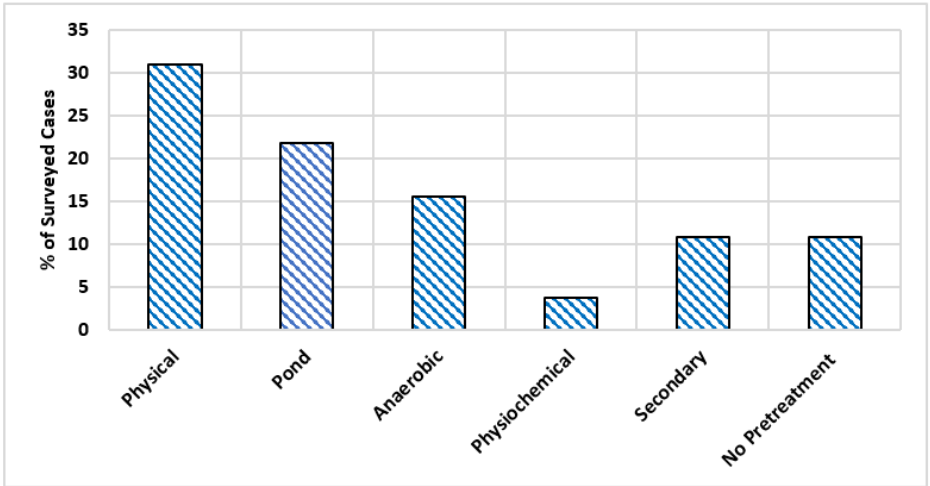
Figure 2. Surveying results of CWs in China presented by June et al., 2011